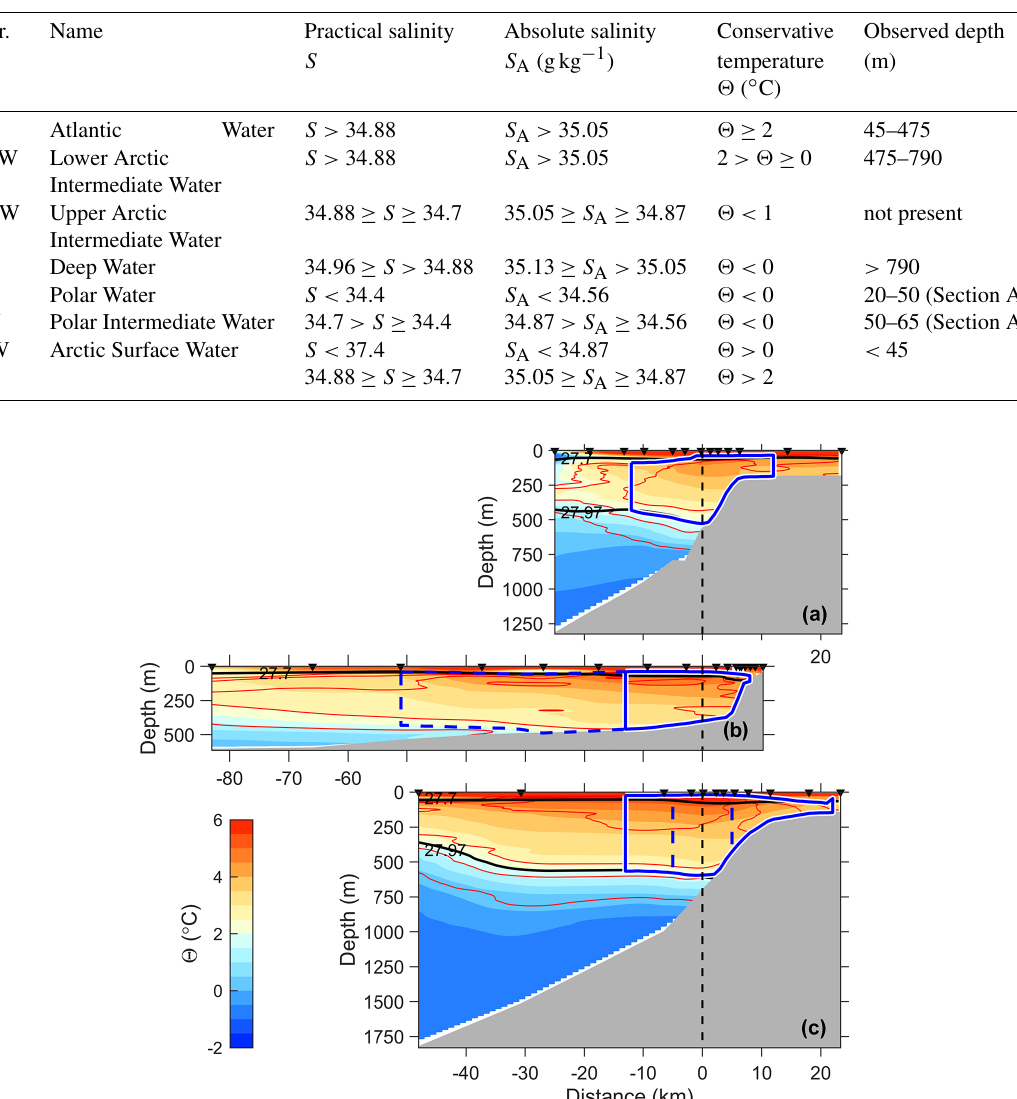
Table 1. Water masses as defined by Swift and Aagaard (1981) and Aagaard et al. (1985). Absolute salinity ( S A ) is calculated from the practical salinity ( S ) at 80 ◦ N and 10 ◦ E and rounded to the nearest hundredth. The last column is the depth range of the different water masses observed in this study.